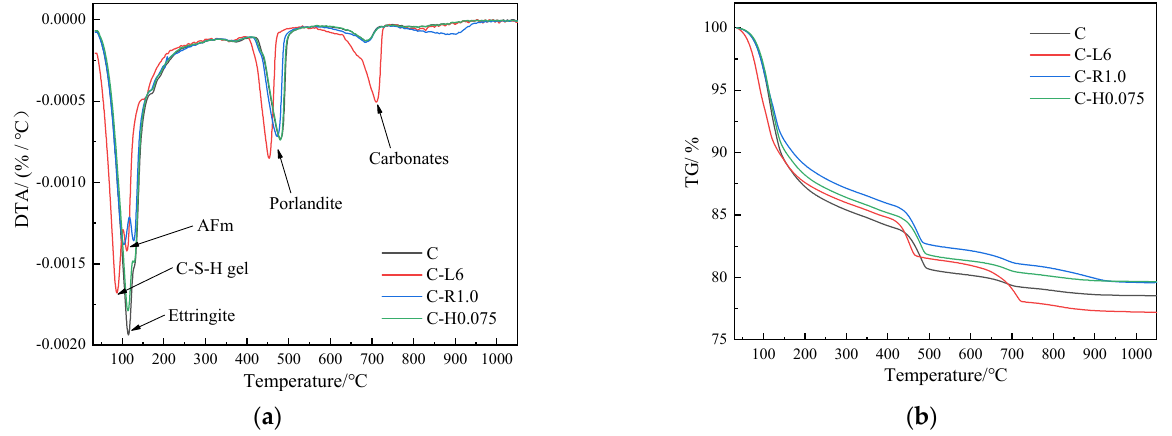
Figure 22. Thermogravimetric/differential thermogravimetry curves for 3 d of different pastes. ( a ) DTA curves, ( b ) TG curves. ( a ) DTA curves, ( b ) TG